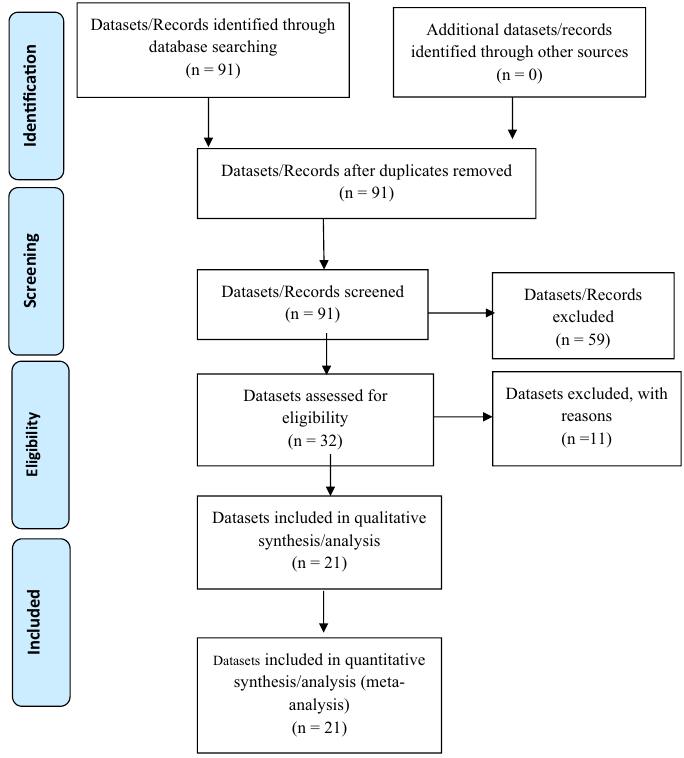
Fig. 1 PRISMA flow diagram for eligibility criteria of